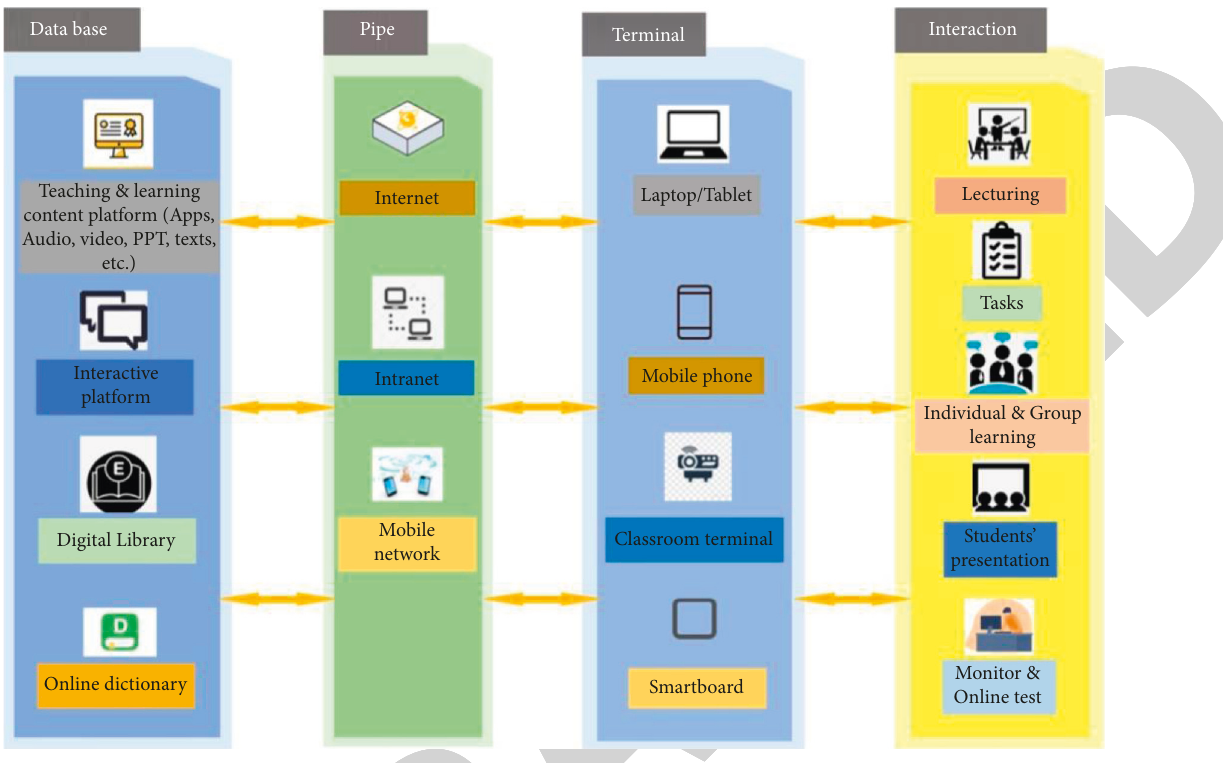
Figure 3: Multimedia teaching